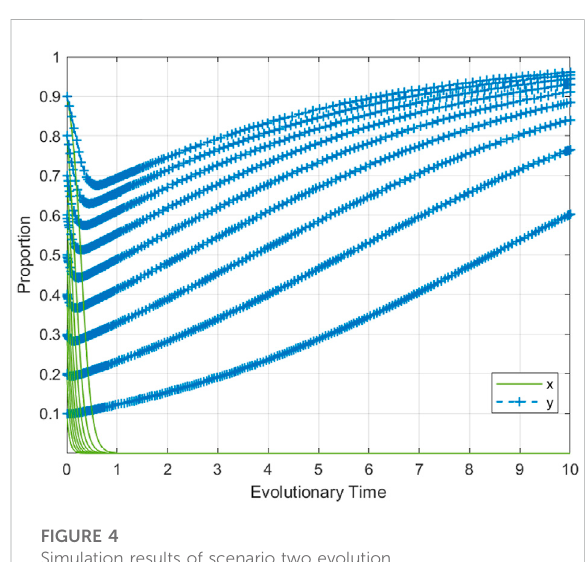
FIGURE 4 Simulation results of scenario two evolution.